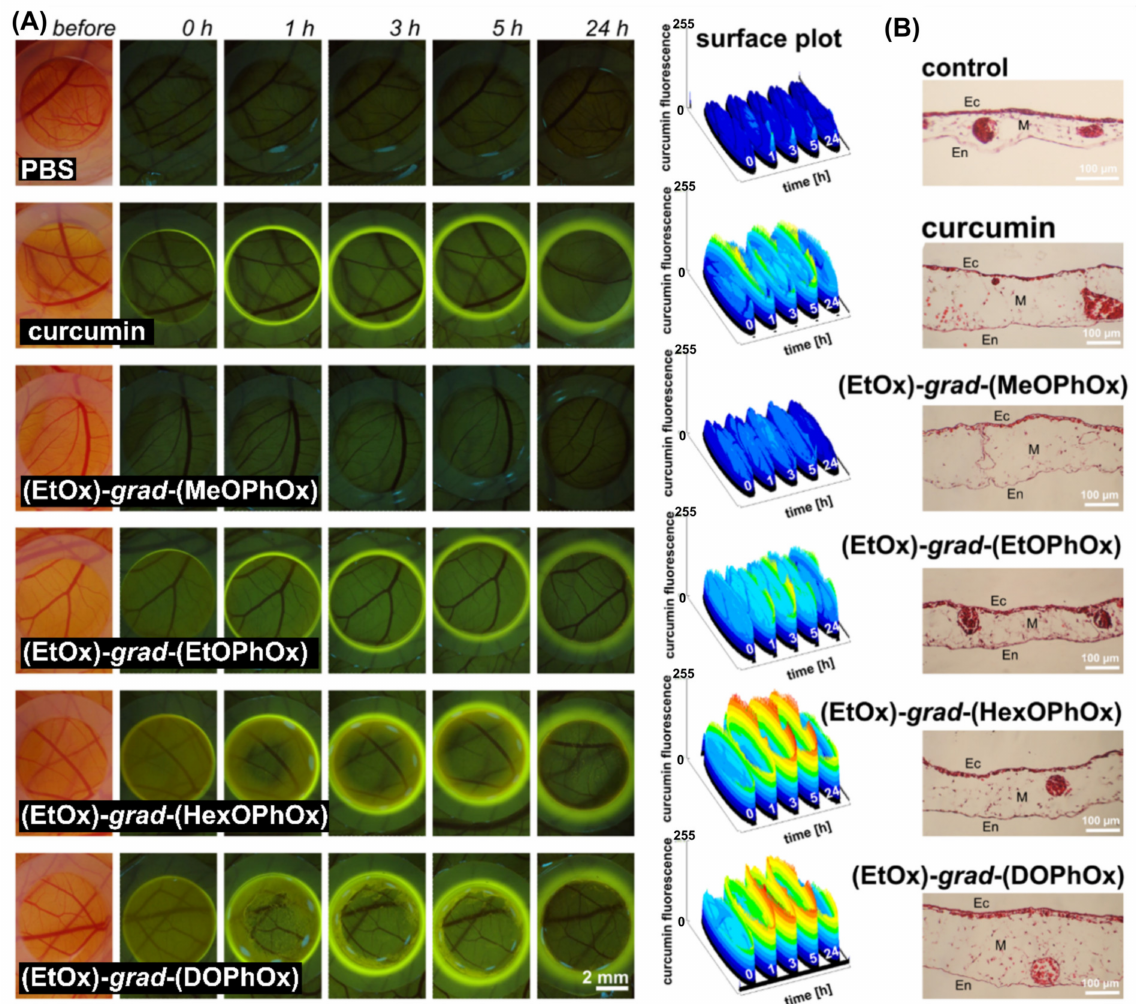
Figure 6. ( A ) Fluorescence pharmacokinetics (0–24 h) of curcumin (yellow fluorescence) on CAM detected before and after topical application of 30 µ L of the solutions of curcumin-loaded POx NPs as denoted in the images. Surface plots represent evolution of curcumin fluorescence intensity in time (intensity values are color-coded and increase from black to red). ( B ) Histology of CAM detected 24 h after administration of compounds. Samples are H&E stained (Ec-ectoderm, M-mesoderm, En-endoderm). The corona-shaped fluorescence maximum was observed at 5 h, as shown by the surface plots. The interaction of curcumin with the silicone ring (as a side-effect), which served as a carrier for the administration of the solutions, was observed throughout the ob- servation period. The most intense curcumin fluorescence in the silicon ring was observed 24 h after administration. Traces of heterogeneously localized curcumin fluorescence on CAM (indicated by rings) were still observed after 5–24 h when (EtOx)-grad-(HexOPhOx) and (EtOx)-grad-(DOPhOx) NPs were administered. Curcumin administration did not significantly damage the tissues of CAM (see histology in Figure 6B). These results indicate that curcumin loaded in (EtOx)-grad-(HexOPhOx) and (EtOx)-grad-(DOPhOx) NPs was highly stable from the very beginning of